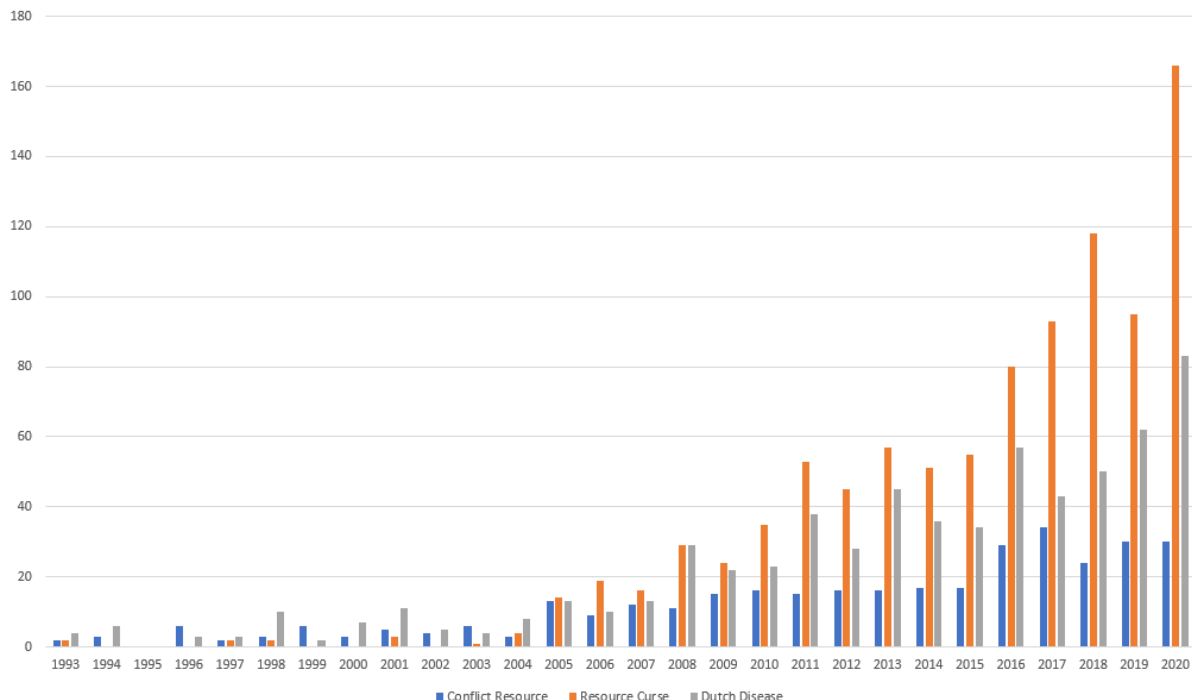
Figure 2. Annual publication distribution 1993–2020 (collected on 22 February 2021).